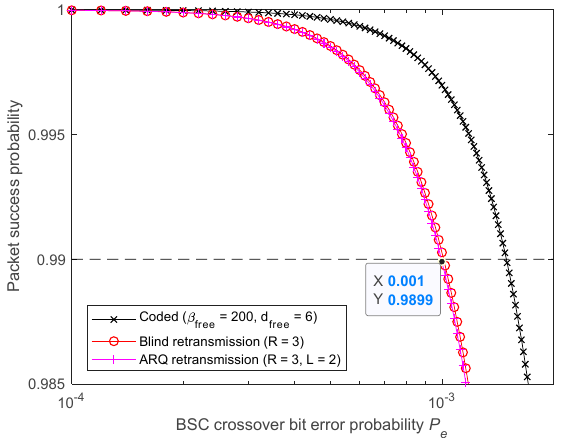
Figure 22. Meeting 99% reliability target by using FEC, BR, and 2-Rep-ACK retransmissions ( L = 2).